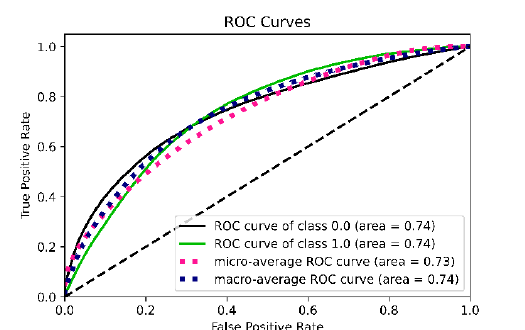
Figure 4. The ROC curve obtained from the LR